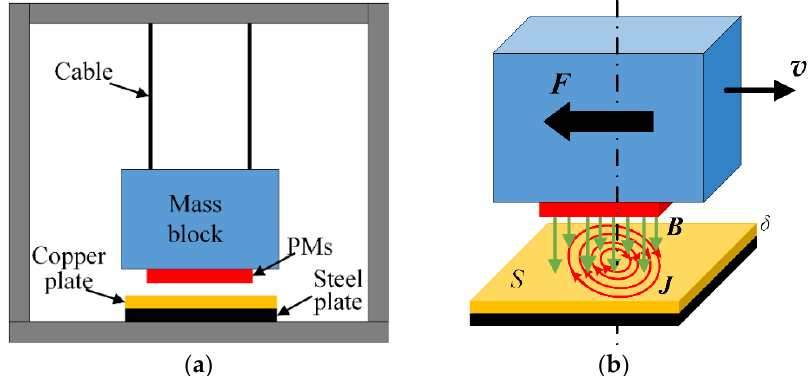
Figure 2. Damping mechanics of the ECD system: ( a ) Scheme of the EC-TMD system; ( b ) Eddy current damping force.